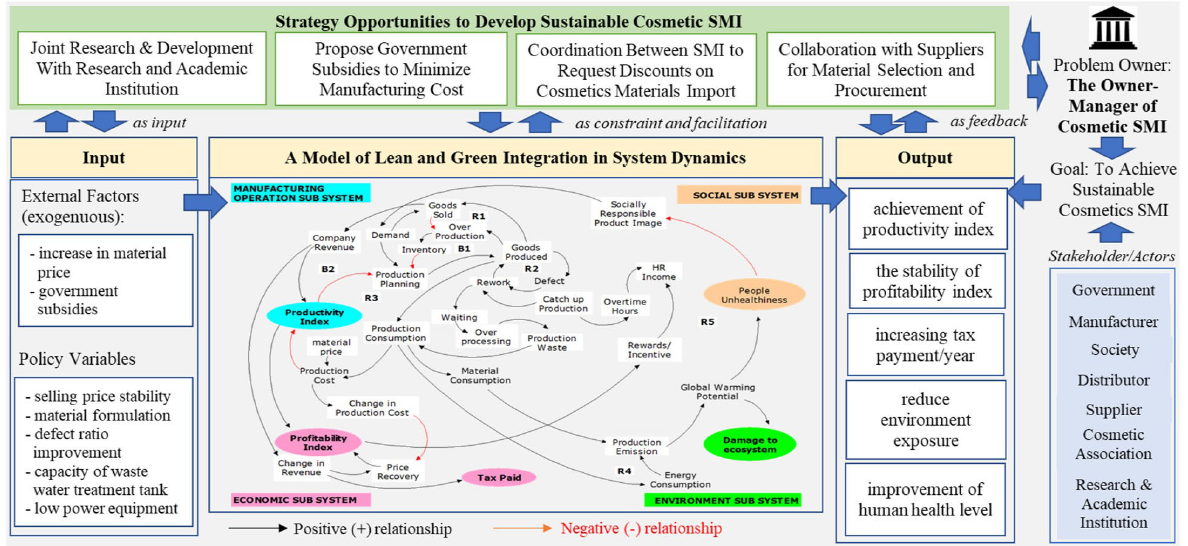
Figure 8. System diagram of the lean and green integration model for achieving sustainable